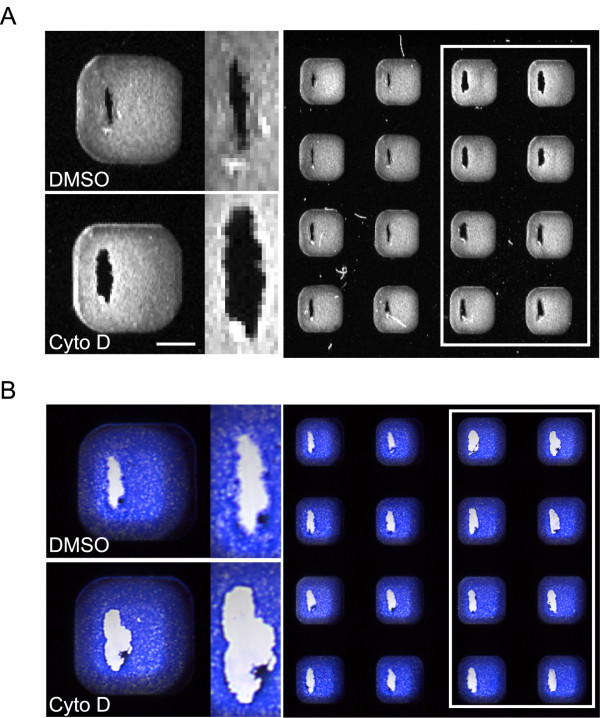
The use of scanners to assay wound healing after 7 hrs recovery. (A) An image of actin-stained wells obtained using a fluorescence scanner. Normal healing wounds (left two columns) can be distinguished from wells treated with a titration of the actin cytoskeleton disrupter cytochalasin D (white box) by the width of the wound and staining at the wound margin. (B) An image of Coomassie-stained wells obtained using a transmitted-light scanner. Normal healing wounds have a more diffuse wound margin, denoting cell migration into the wound, than wells treated with cytochalasin D (white box). Bar 1 mm.